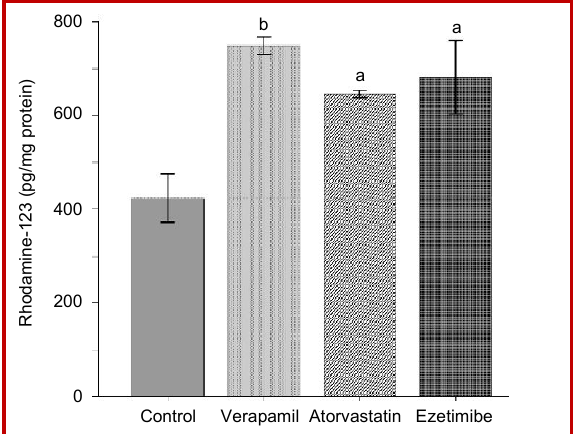
Figure 3: Effects of verapamil (300 µM), atorvastatin (100 µM) and ezetimibe (100 µM) on intracellular accumulation of Rho123 in Caco-2 cells (n = 4). Bars show mean ± SD. a and b represent significantly different from control (untreated) cells (p<0.05 and p<0.01, respectively)